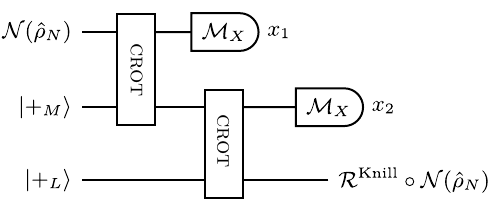
FIG. 2. Bosonic version of Knill-type error correction for number-phase codes. In the case of noise-free ancillae the circuit implements a logical (qubit to qubit) channel, also referred to as the telecorrection circuit. The recovery map R Knill corresponds to a change of the Pauli frame and is determined by the measure- ment outcomes (cid:13) x = ( x 1 , x 2 ) ; see the main text for details. Thus, a logical error on the output state occurs only if the decoding of the M X measurement is